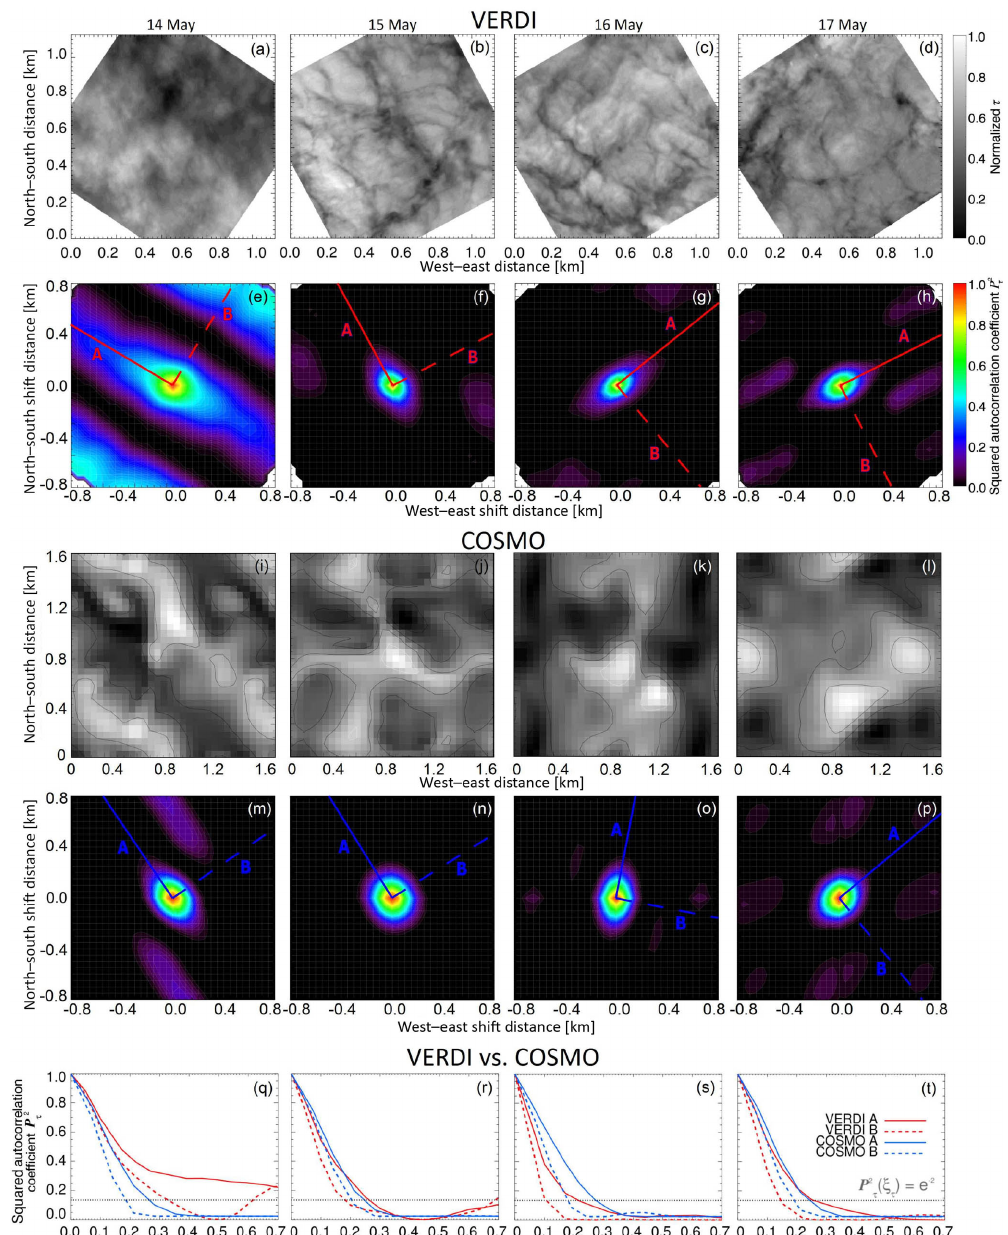
Figure 7. (a–d) Exemplary selected sections of fields of τ meas observed during VERDI from 14 to 17 May 2012. (e–h) Mean 2-D autocor- relation coefficients P 2 τ, meas derived for fields of τ meas from VERDI. (i–l) Exemplary selected fields of τ sim simulated with COSMO (50m spatial resolution) for the VERDI cases from 14 to 17 May 2012. (m–p) Mean 2-D autocorrelation coefficients P 2 derived for fields τ, sim of τ sim . (q–t) Decorrelation length ξ τ along strongest (straight blue and red lines) and weakest (dashed blue and red lines) extents of 2-D autocorrelation coefficients derived from P 2 τ, meas in panels (e) – (h) and P 2 in panels (m) – (p) , τ, sim